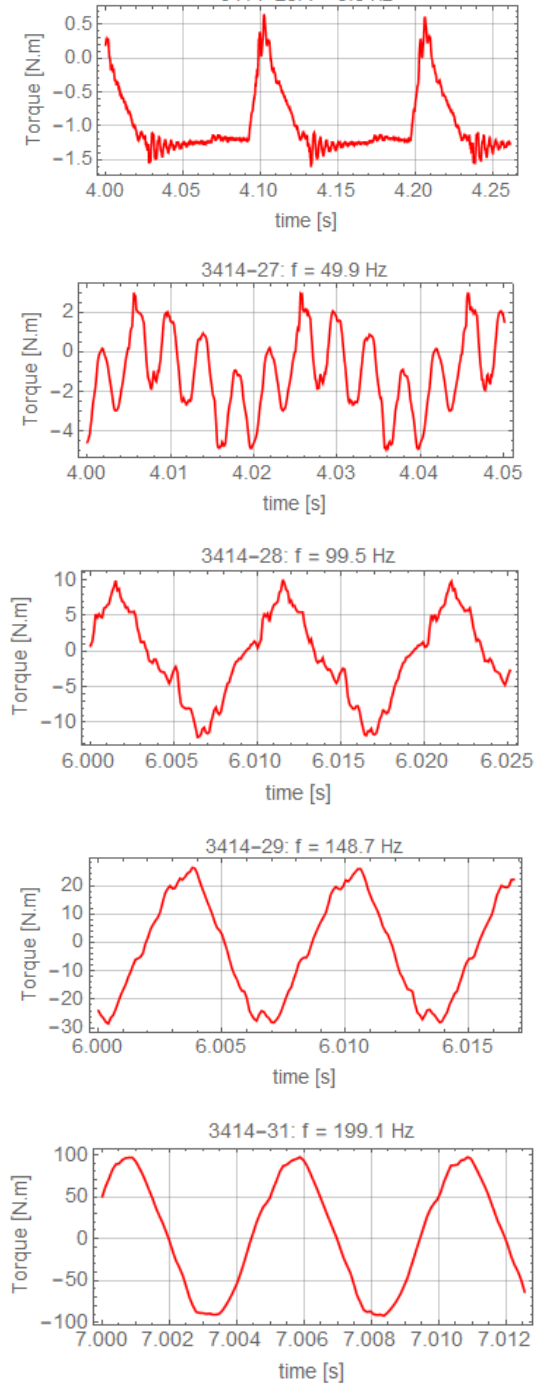
Figure Torque measured by the strain gauges during 8. oscillations in the frequency range 𝑓 = 10 − 200 Hz in still-air conditions.